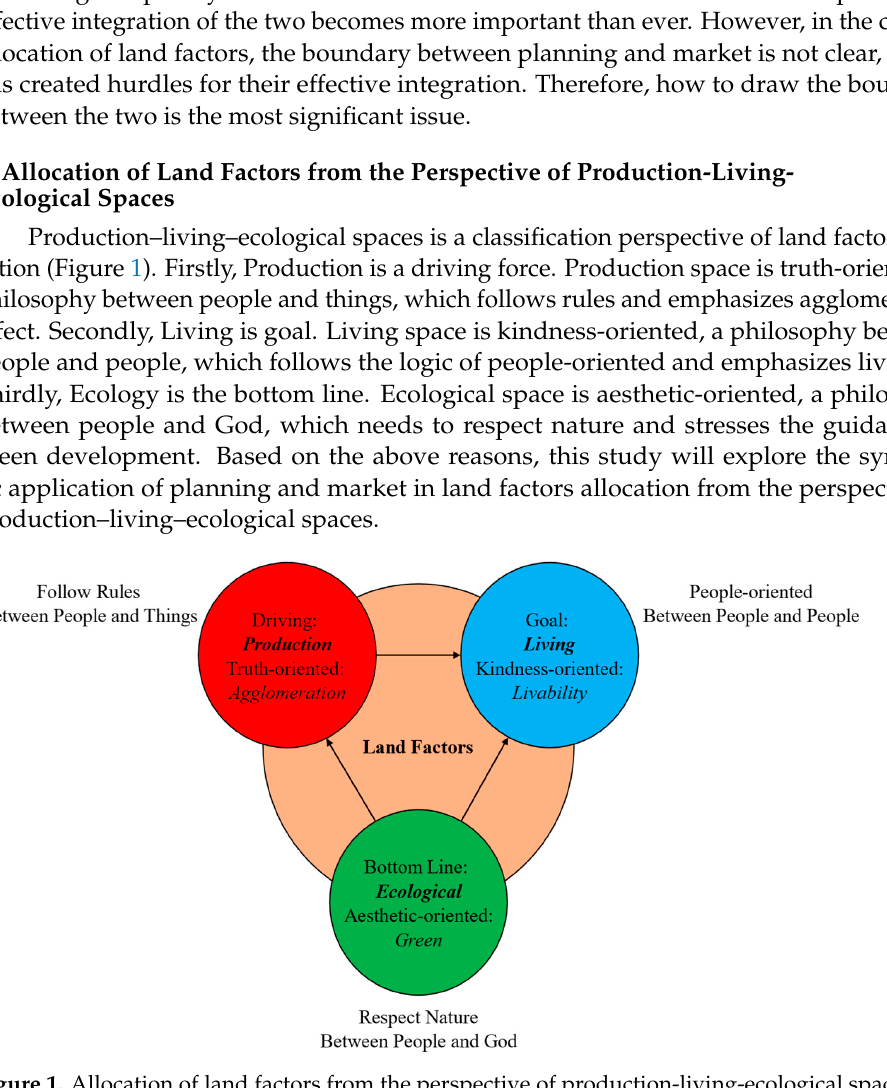
Figure 1. Allocation of land factors from the perspective of production-living-ecological spaces.